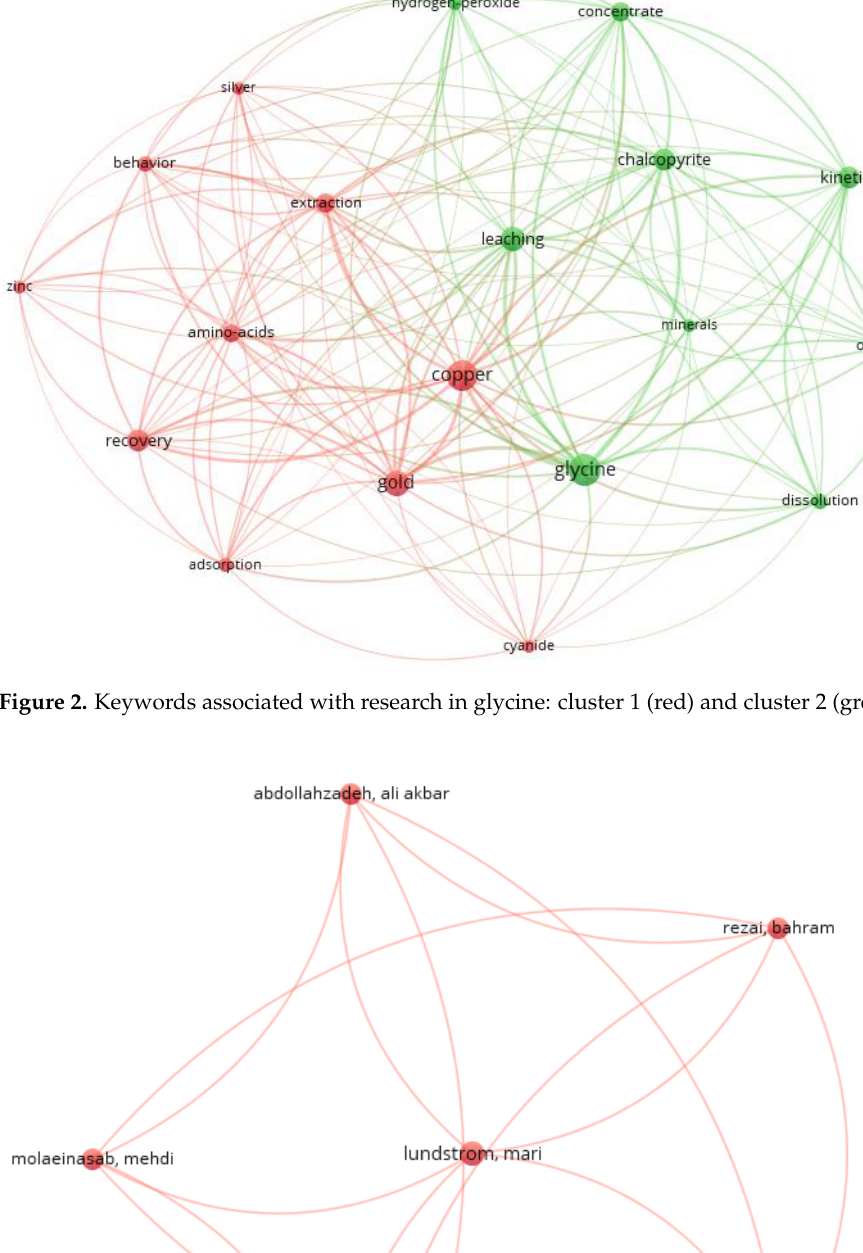
Minerals 2022 , 12 , x FOR PEER REVIEW